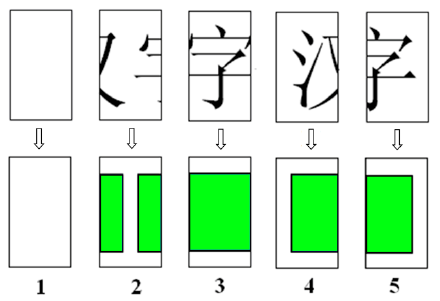
Figure 3. Five types of graphical Chinese characters. The numbers 1, 2, 3, 4, and 5 indicate different types of graphical Chinese characters.